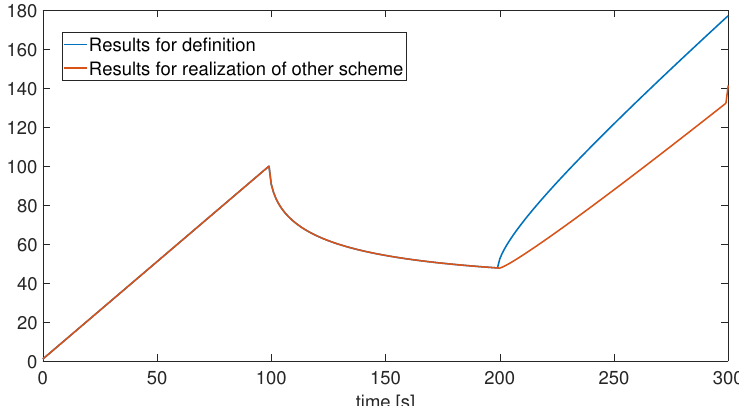
to switching. D B